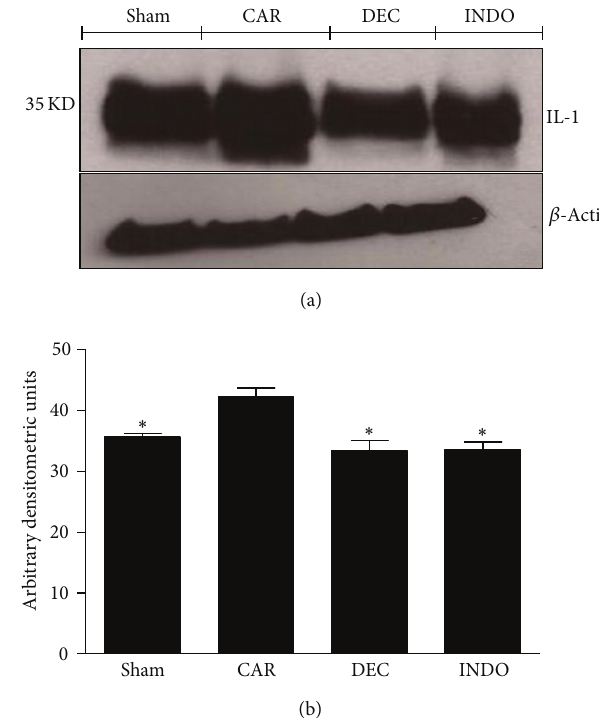
Figure 10: Effects of DEC on carrageenan-induced COX-2 expres- sion in the lung. Basal expression of COX-2 was detected in lung samples from the sham group, whereas COX-2 levels were substantially elevated in lung tissue obtained from animals 4h after carrageenan injection. DEC treatment reduced the expression of COX-2, but treatment with indomethacin did not decrease the levels of COX-2 (a) and (b). (a) Representative blot of lysates obtained from pool 4 animals per group; (b) data expressed as mean ± S.E.M. of 4 replications for each group; ∗ 𝑃 < 0.05 versus carrageenan; ∘ 𝑃 < 0.05 versus DEC.